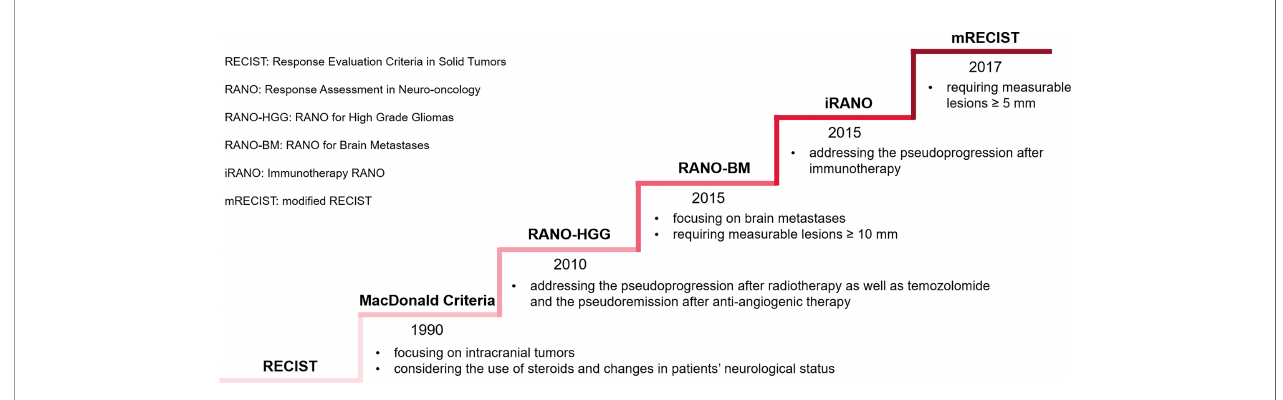
FIGURE 4 | Evolving criteria of response assessment to BMs. The ladder rises by the time a standard is fi rst released rather than